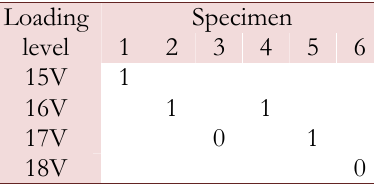
Table 3: Results of fatigue loading on six specimens (design 1) for the fatigue limit estimation using the “staircase” method. The specimen failure is indicated as 1, while the specimen nonfailure is indicated as 0.